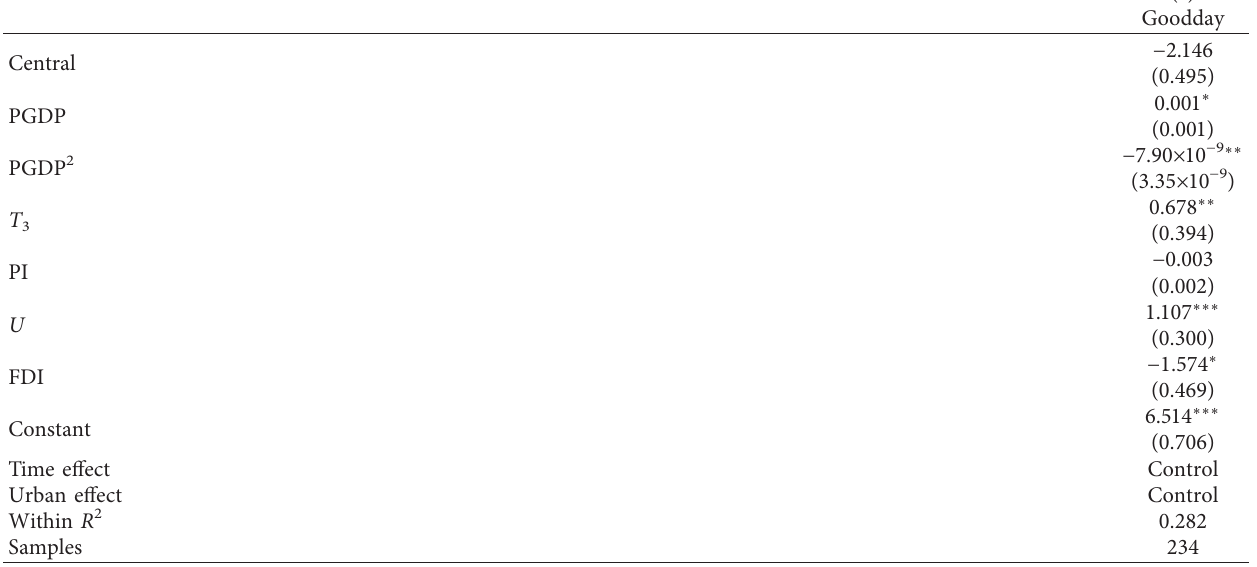
Table 3: Common trend